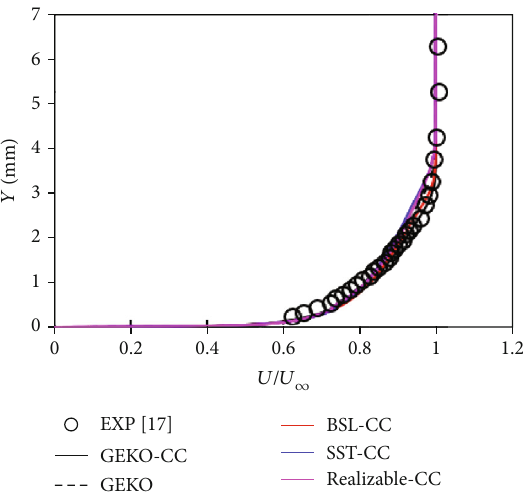
Figure 5: Velocity pro fi les 1mm upstream from the base